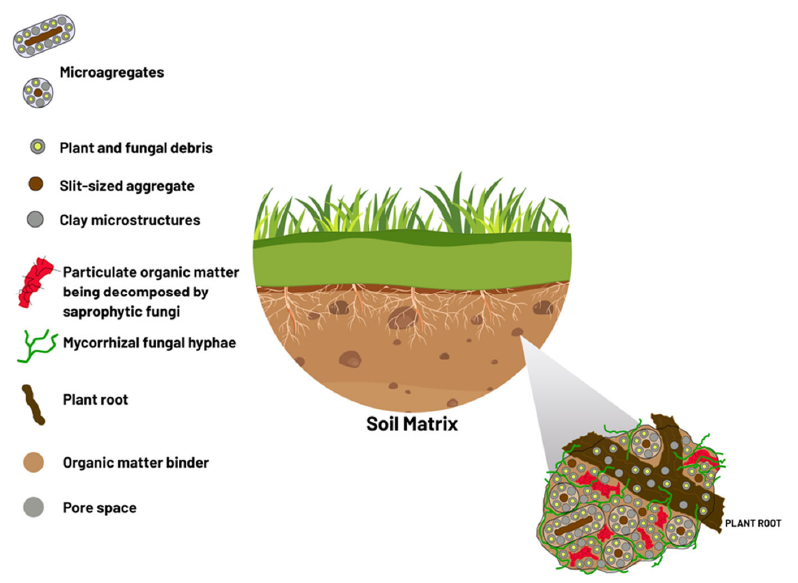
Figure 2. Soil matrix, aggregation and organic allocation induced by plant and microbial activity in the